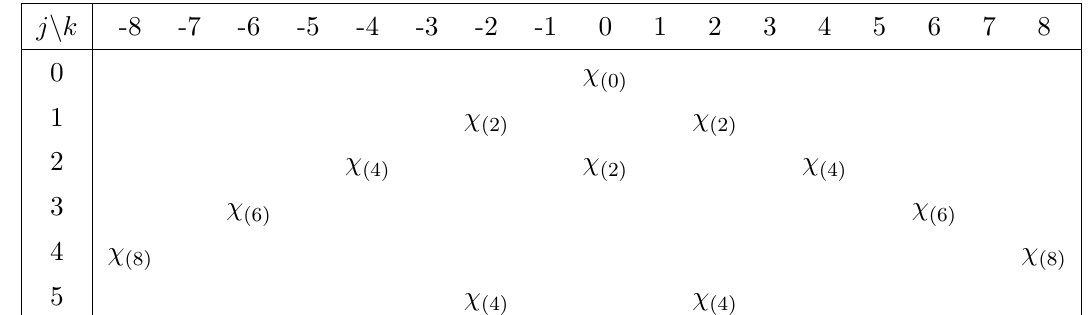
Table 8. Nonvanishing coe(cid:14)cients a (1) of the Sp(1) characters (cid:31)